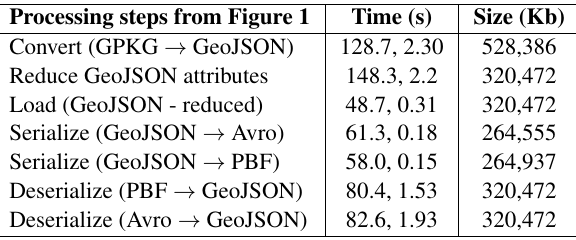
Table 3. Results of Experiment 3 using the original GPKG file: mean and standard deviation of the time required for each processing step and size of the resulting files.